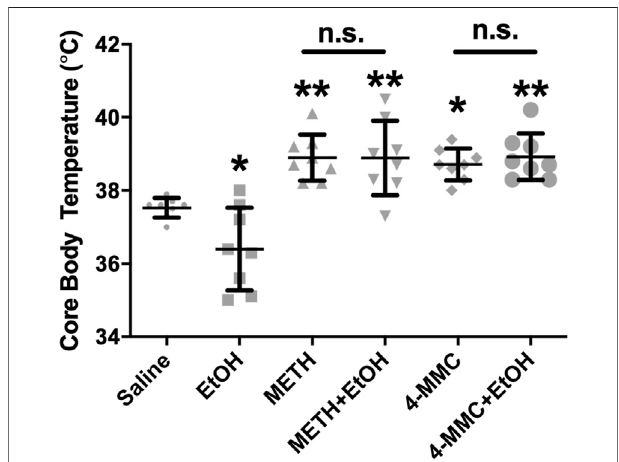
FIGURE 2 | Effect of treatment on body temperature ethanol (EtOH) decreased while all other treatments including the stimulants, increased core body temperatures as assessed 30 min after the fi rst drug administration on Day 1 of the experiment. The data points are means ± SEM for n (cid:1) 8 per group. * p < 0.05 and ** p < 0.01 compared with saline-control (Tukey test); n. s., not signi fi cant. 4-MMC, 4-methylmethcathinone; EtOH, ethanol; METH,